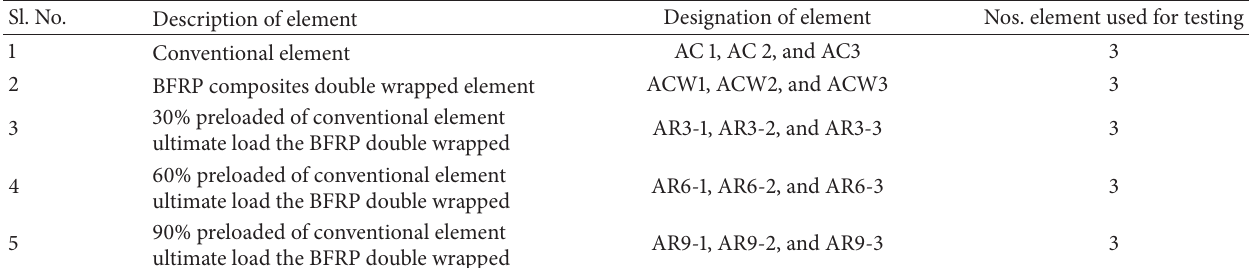
Table 10: Schedule of RCC pile elements testing program.